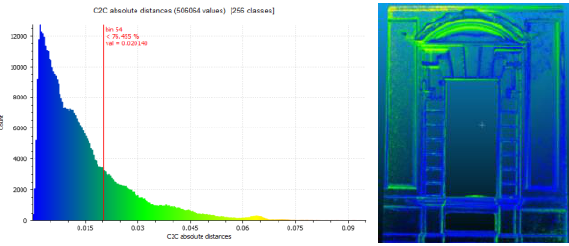
Figure 9. Comparison between TLS point cloud and ReCap point cloud on two windows of the